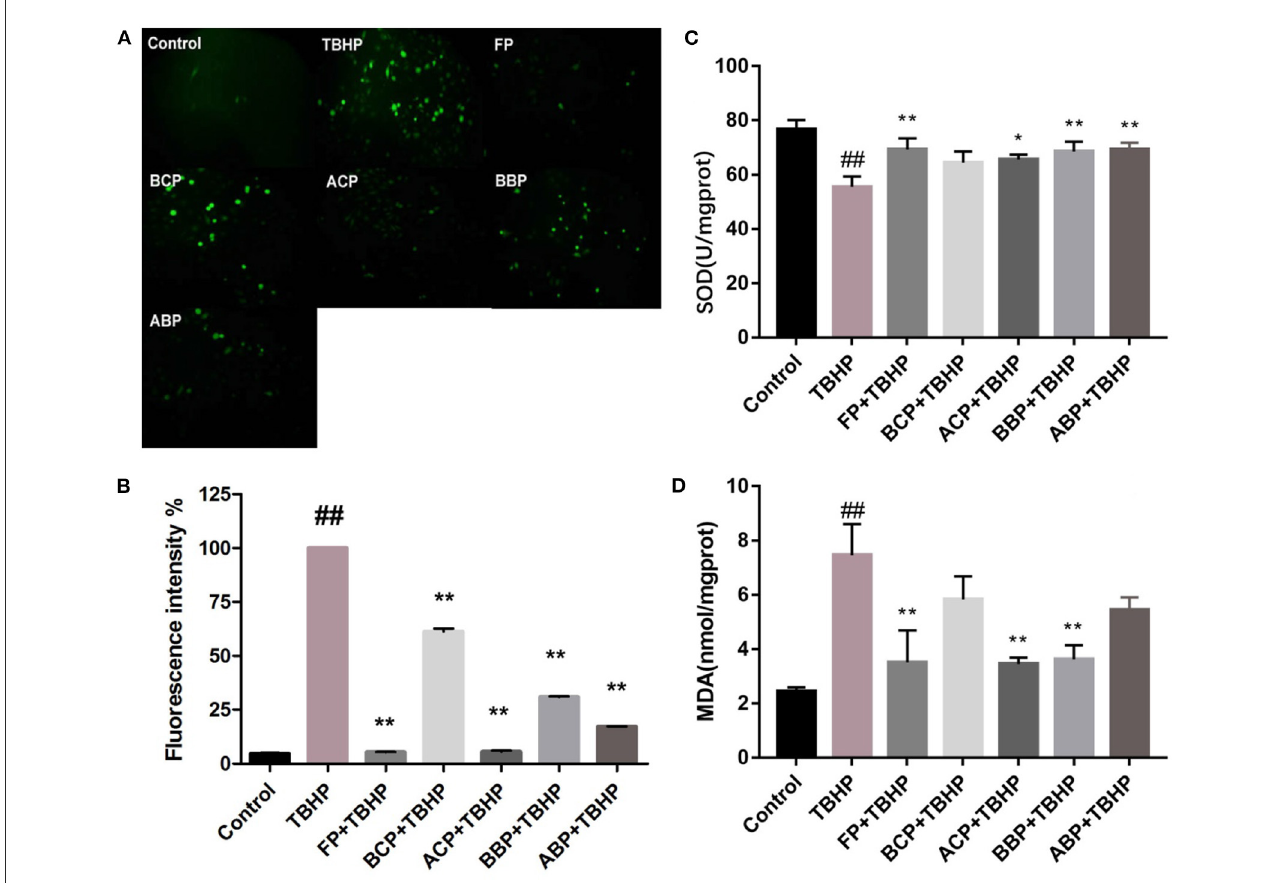
FIGURE4 Influence of hazel leaf phenolics on ROS (A, B) , SOD (C) , and MDA (D) in TBHP-stimulated HUVEC cells, values are expressed as mean ± SD, ## p < 0.01 vs. Control, ** p < 0.01 vs. TBHP, * p < 0.05 vs.